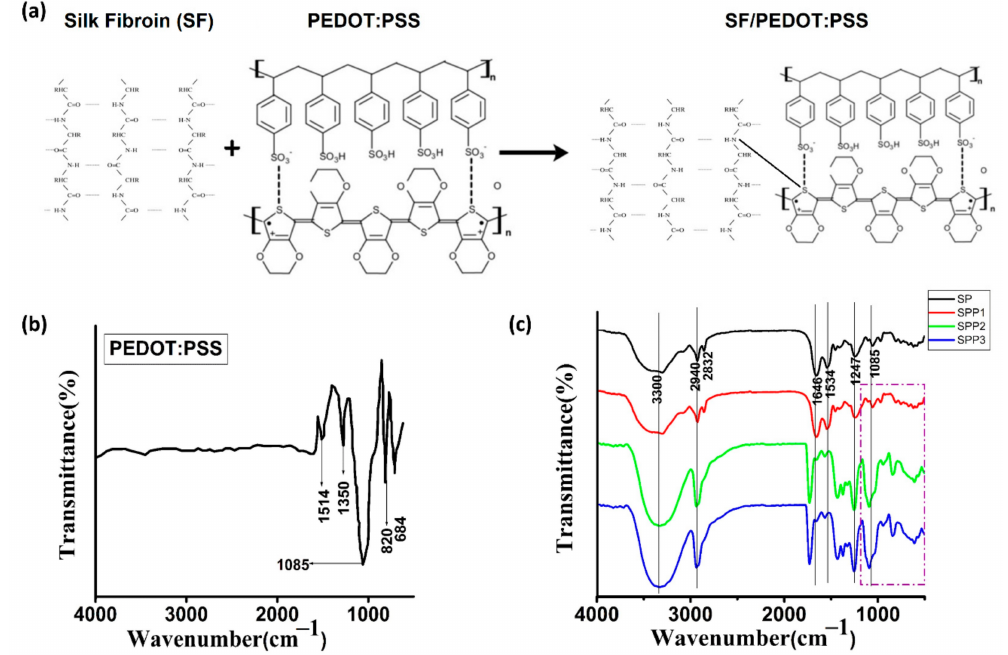
Figure 1. ( a ) Mechanism of fabrication of SF / PEDOT:PSS matrix; ( b ) FTIR spectra of PEDOT:PSS and ( c ) the composite matrices reveal peaks of corresponding to β sheet structure of SF and respective major absorption peaks of PEDOT:PSS without any major